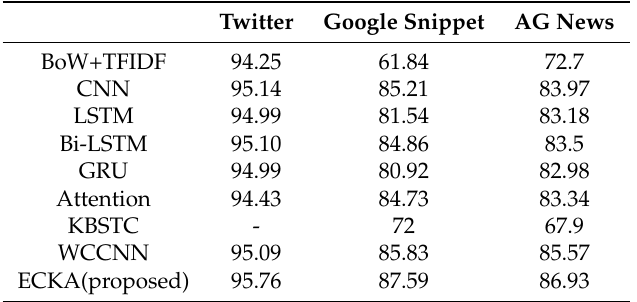
Table 4. Text classification comparison of different models.